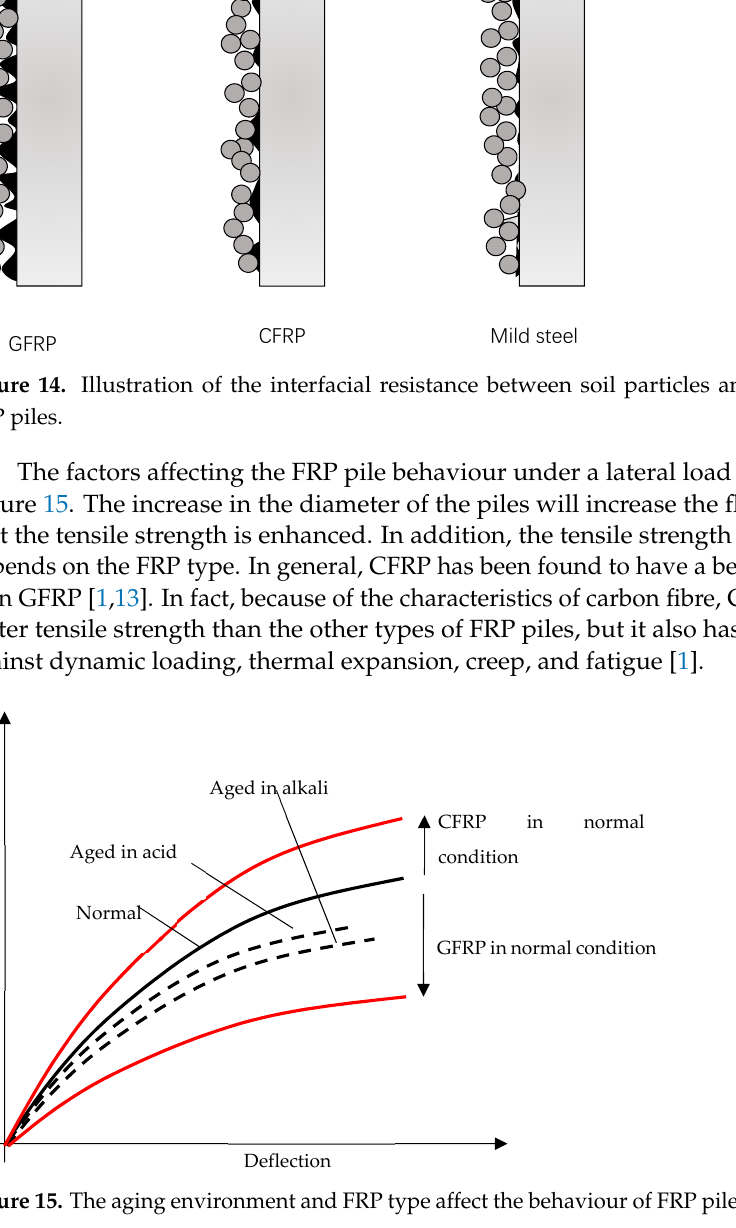
where Q (cid:2929) is the shaft resistance, C is the pile circumference, L is the pile embedment, and q is the average shear strength. s q (cid:2929) is the average shear strength.